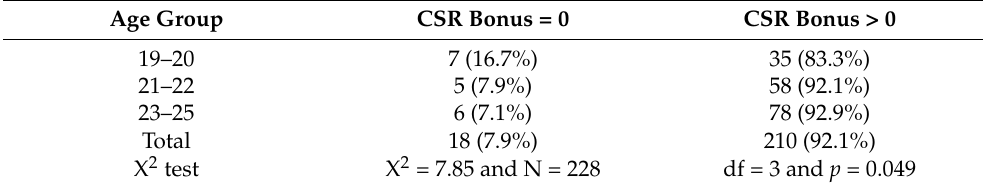
Table 1. Contingency table H 0 age—the frequency of no CSR bonus payers is NOT the same in age groups (age